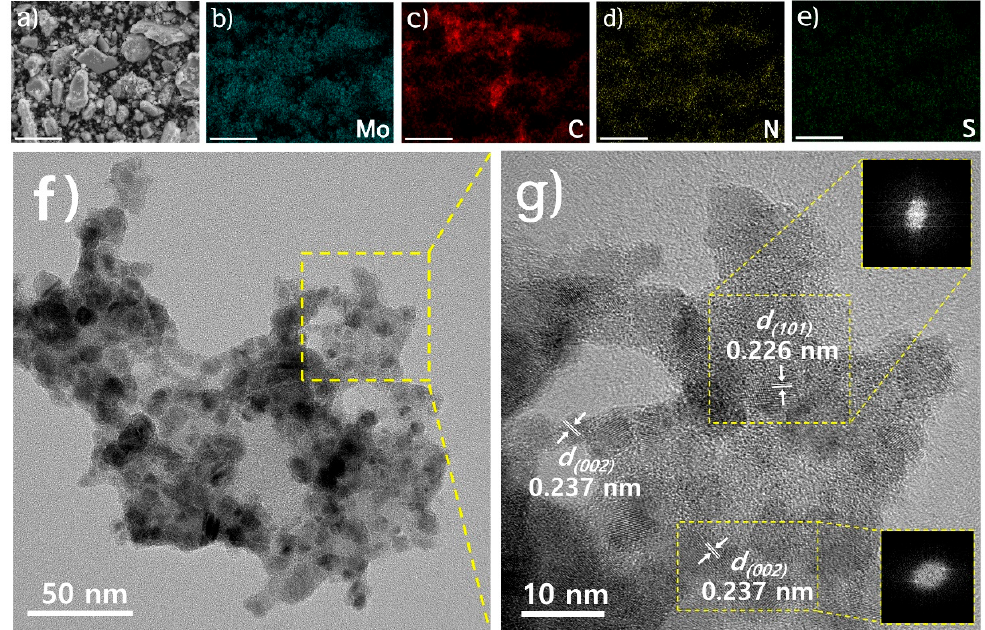
Figure 1. ( a ) SEM image of Mo 2 C/N,S-C and corresponding SEM-EDS elemental mapping for ( b ) Mo, ( c ) C, ( d ) N, and ( e ) S (scale bar = 10 um). ( f ) TEM and ( g ) HR-TEM images of Mo 2 C/N,S-C. Insets in (g) denote FFT images.